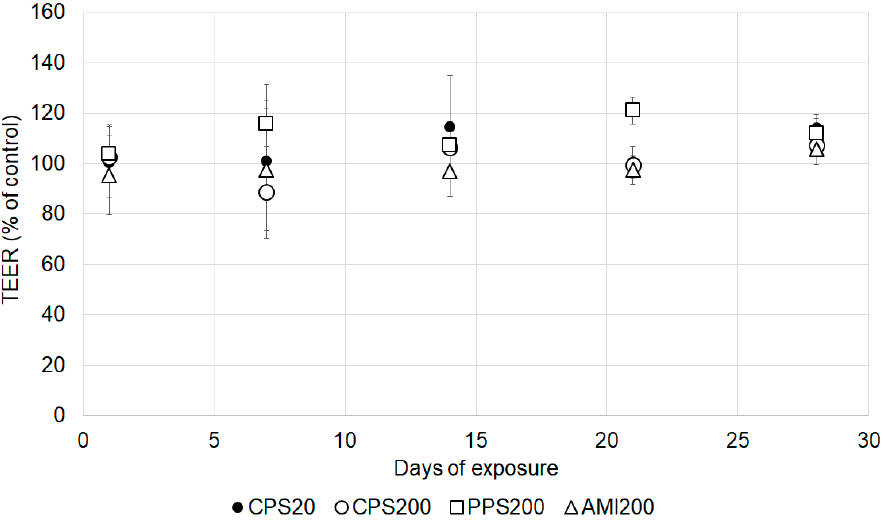
Figure 5. Relative changes of transepithelial electrical resistance (TEER) values in particle exposed Calu-3 cells. Calu-3 cells exposed to solvent alone were defined as 100%.